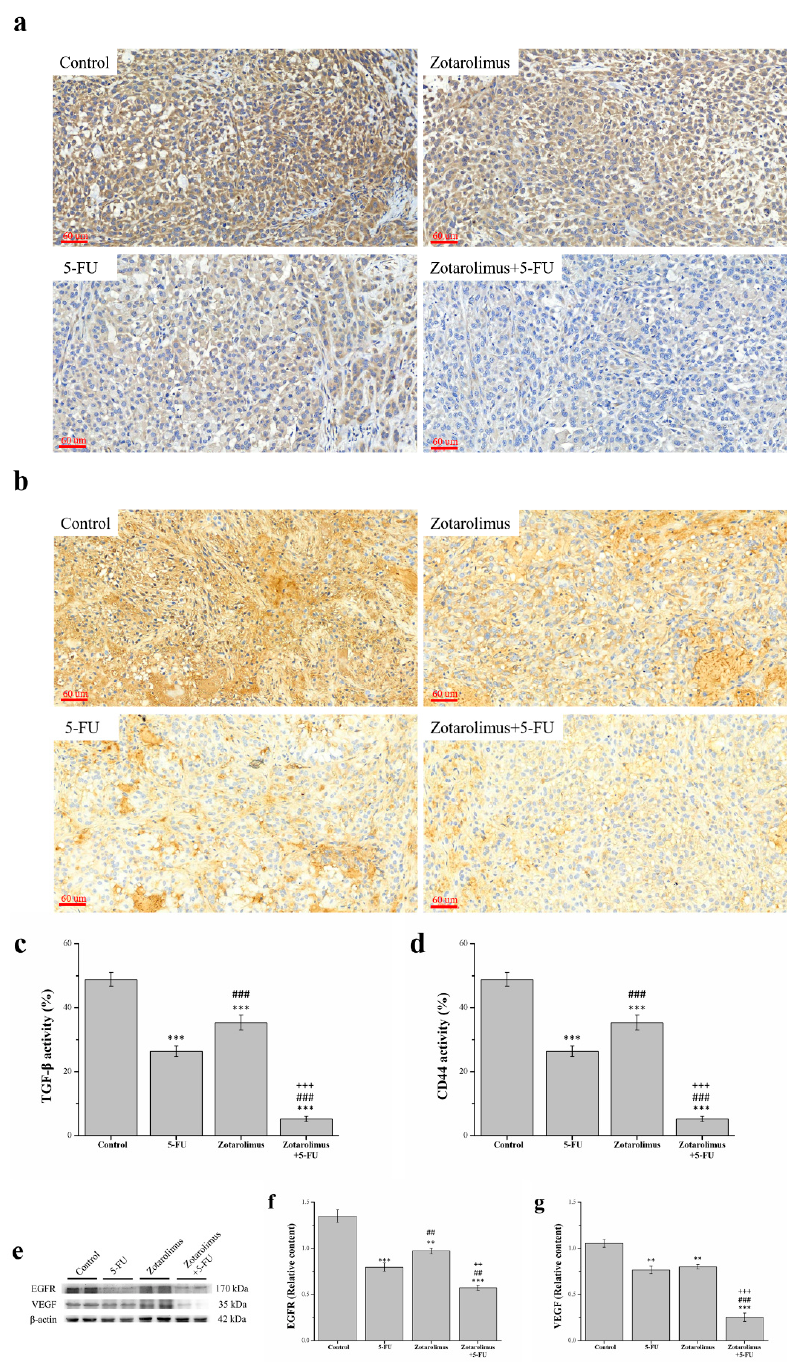
Figure 6. Immunohistochemical expression of ( a ) TGF- β and ( b ) CD44 and a comparison of the expression levels of ( c ) TGF- β and ( d ) CD44. Western blot analysis ( e ) showing the expression of metastasis-related factors extracted from tumors in a representative blot. Expression of ( f ) VEGF and ( g ) EGFR in the A549 tumor masses from BALB/cByJNarl in control mice and mice given different treatments, including 5-FU (100 mg/kg/week), zotarolimus (2 mg/kg/day), and zotarolimus (2 mg/kg/day) combined with 5-FU (100 mg/kg/week). All data are presented as mean ± standard deviation, n = 7 per group. ** p < 0.01 and *** p < 0.001 compared with the control group. ## p < 0.01 and ### p < 0.001 compared with the 5-FU-treated group. ++ p < 0.01 and +++ p < 0.001 compared with the zotarolimus-treated group. Scale bars = 60 µm.